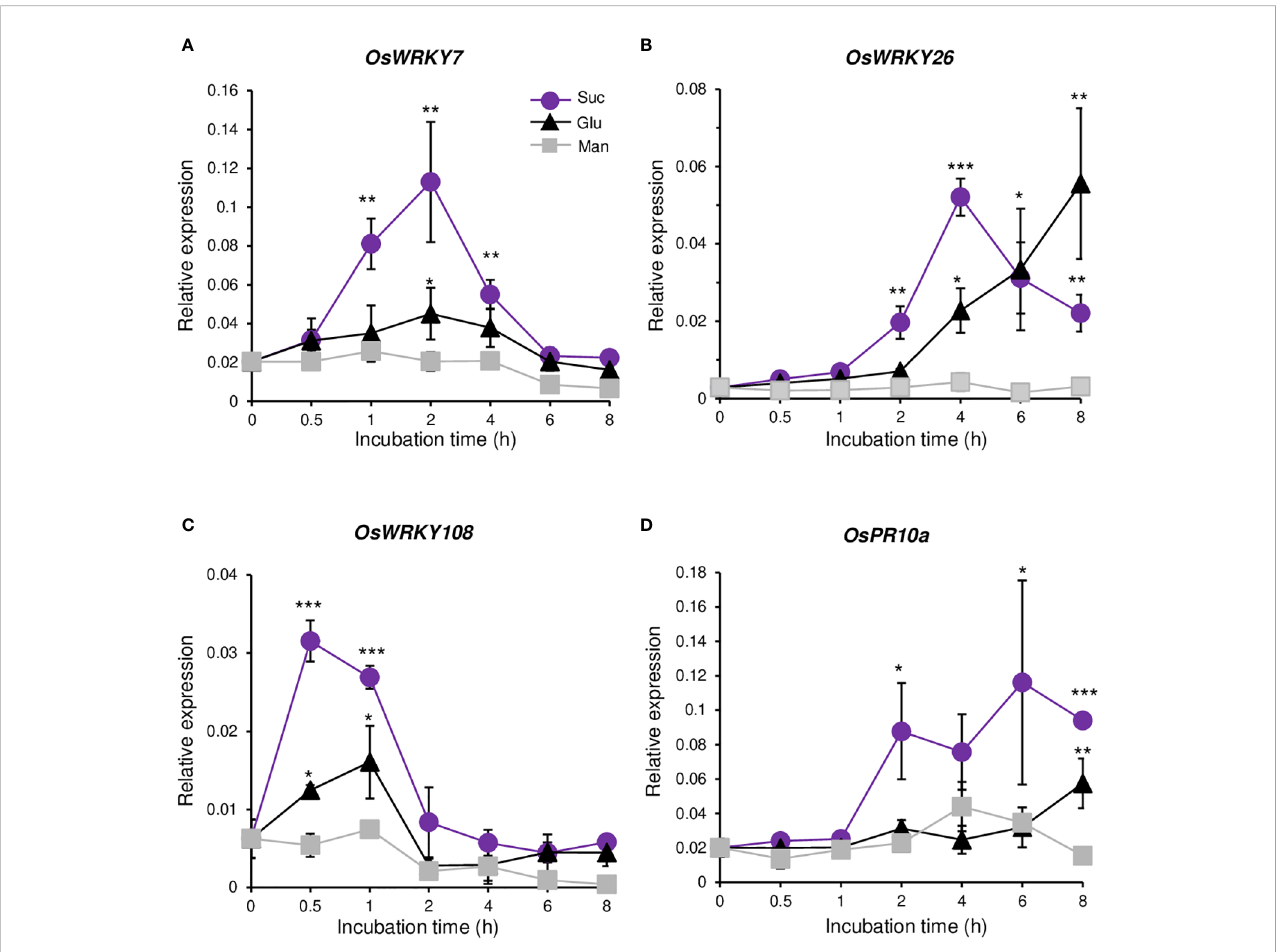
FIGURE 1 Response to sugars. Quantitative RT-PCR analyses of OsWRKY7 (A) , OsWRKY26 (B) , OsWRKY108 (C) , and OsPR10a (D) in Oc cells after addition of 3% sucrose (Suc), 3% glucose (Glu) or 3% mannitol (Man). The gene expression levels are relative to those of OsActin1 . Error bars indicate standard deviations; n = 3 or more. Statistical signi fi cance is indicated by *(P < 0.05) **(P < 0.01) and ***(P <